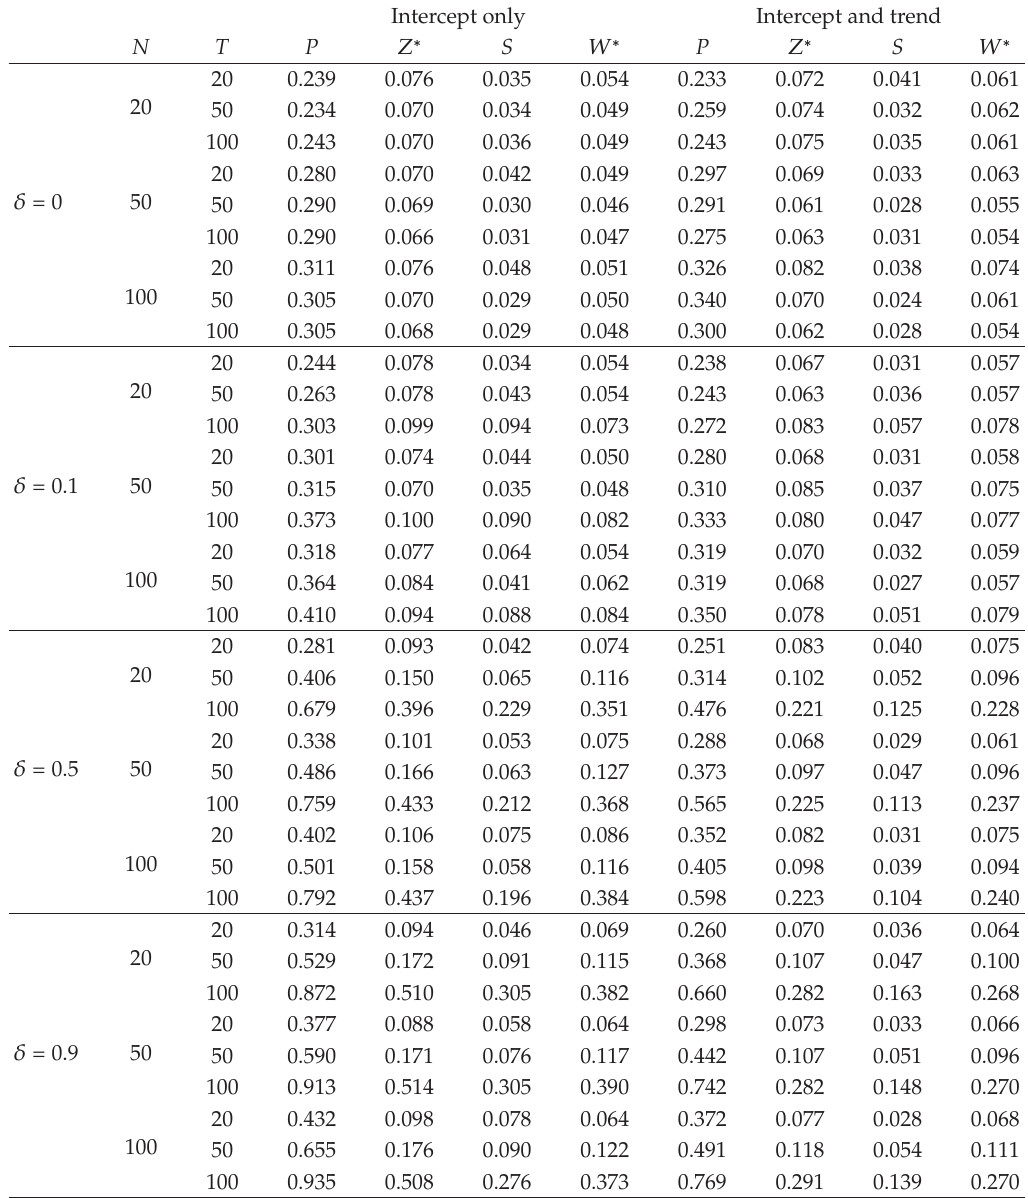
Table 2: Size and power of panel unit root tests: no serial correlation, cross-section dependence driven by a common